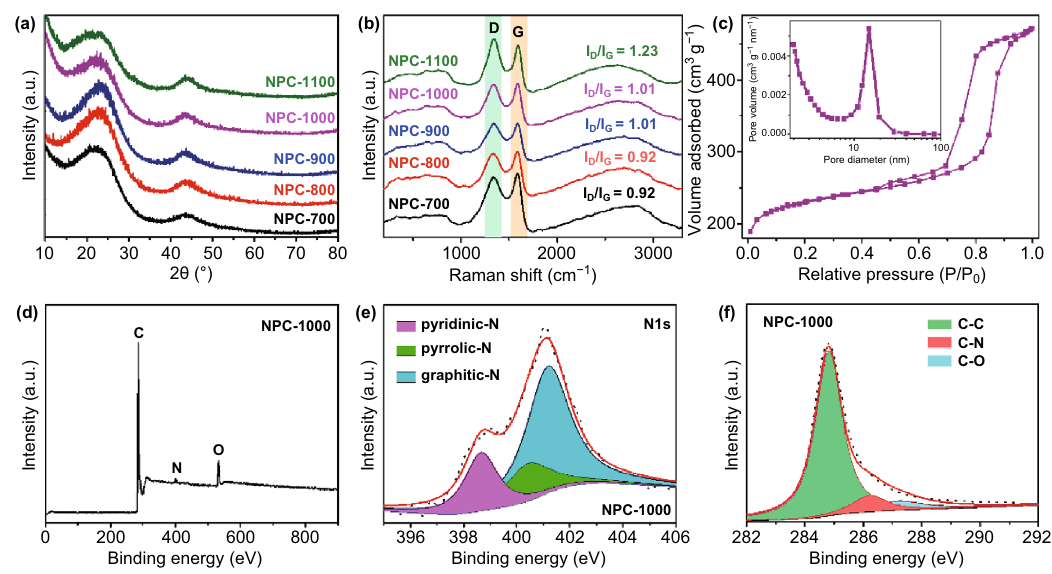
Fig. 3 a XRD patterns and b Raman spectra of different NPCs, c nitrogen adsorption–desorption isotherms of NPC-1000 (inset: pore-size dis- tribution), d XPS spectra, and e , f high-resolution N 1s and C1s spectra of